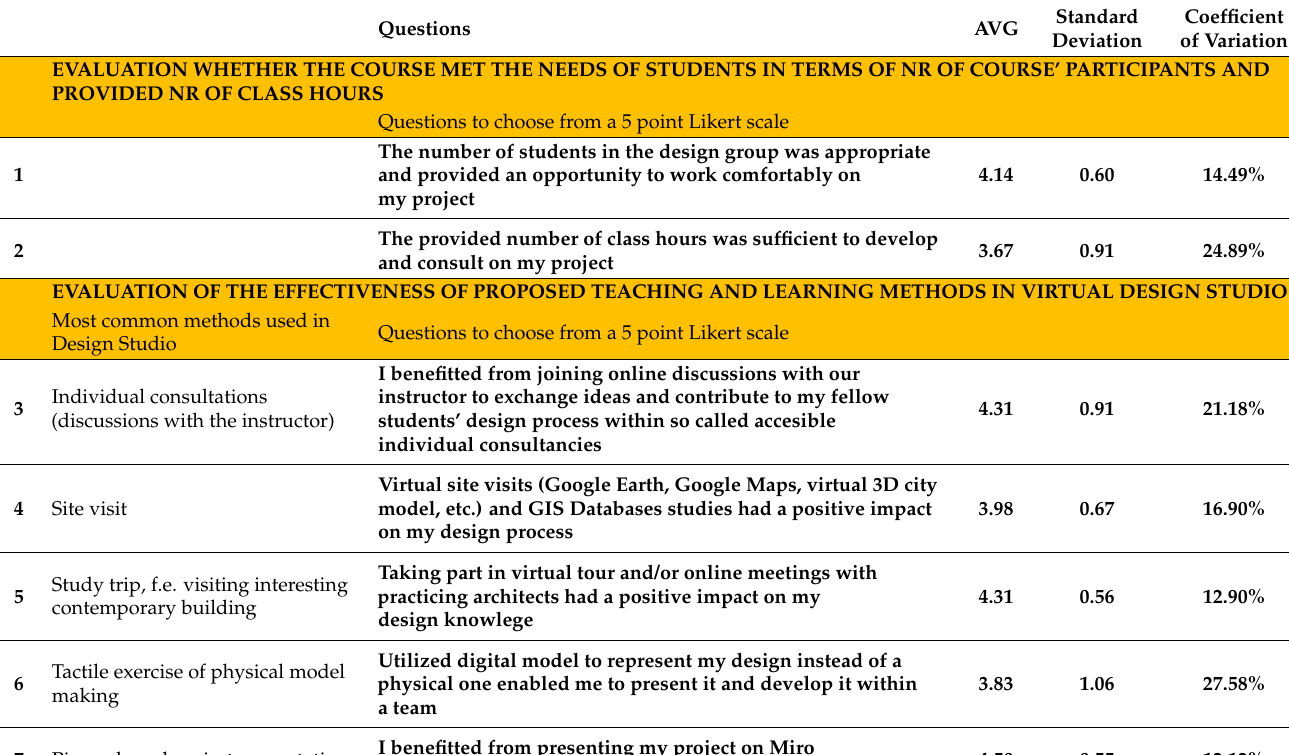
Table 2. Results of the survey—part 1. Questions 1–15 to choose from a 5-point Likert scale (ranging from 1 to